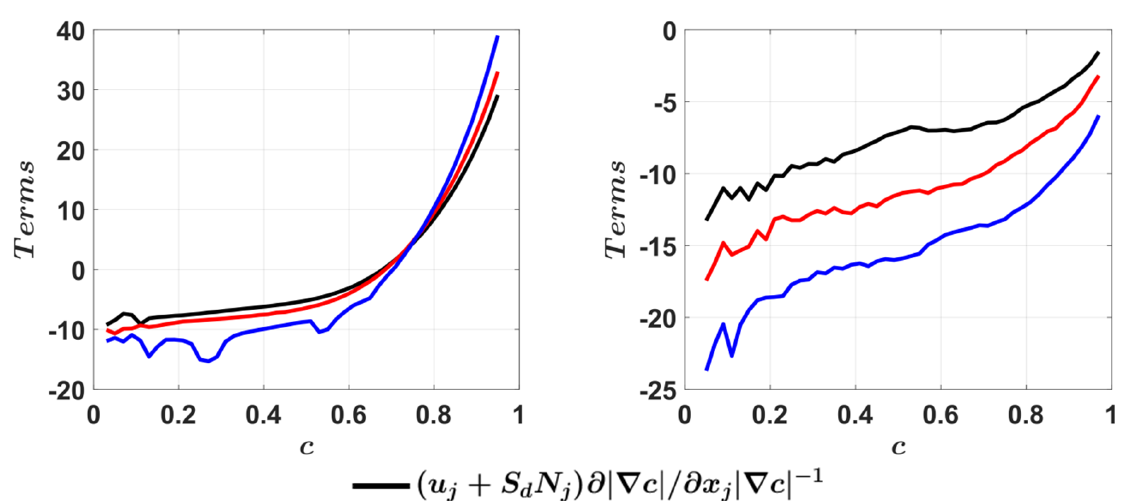
Figure 13. Profiles of the normalised mean values of |∇ c | − 1 ( u j + S d N j ) ∂ |∇ c | / ∂ x j × δ th / S L conditioned upon c for u (cid:48) / S L = 4.0 (black) 6.0 (red) and 8.0 (blue) for statistically planar turbulent premixed flames (first column) and homo- geneous MILD combustion cases (second column). Note the difference in scales between the premixed flame and MILD combustion cases.